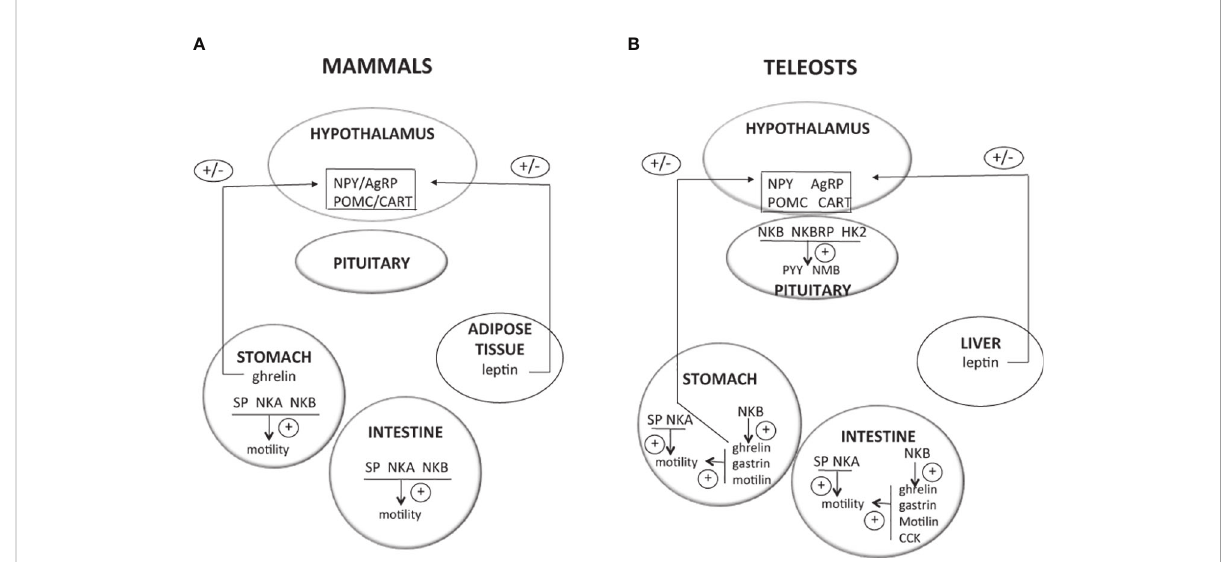
FIGURE 3 Direct effects of TAC peptides in the control of food intake and gut motility in mammals and teleosts. TAC peptides can act directly at different levels (hypothalamus, pituitary, and gastrointestinal tract) to in fl uence food intake and gut motility. In mammals (A) , most of the available studies report the stimulatory effects of tachykinins on gut motility. In teleosts (B) , recent in vitro studies are emerging, showing direct effects of TAC3 and TAC4 peptides on the expression of neuropeptides highly expressed in the pituitary and that are involved in the central control of food intake. These TAC peptides can also in fl uence the expression of genes from the gut that control its motility. For more details and for data from in vivo experiments, please refer to part 3 of this review. +, direct stimulatory effect; -, direct inhibitory effect; 0, no direct effect; AgRP, agouti related peptide; CART, cocaine and amphetamine regulated transcript; CCK, cholescystokinin; HK2, hemokinin 2; NKA, neurokinin A; NKB, neurokinin B; NMB, neuromedin B; NPY, neuropeptide Y; POMC, proopiomelanocortin; PYY, peptide YY; SP, substance